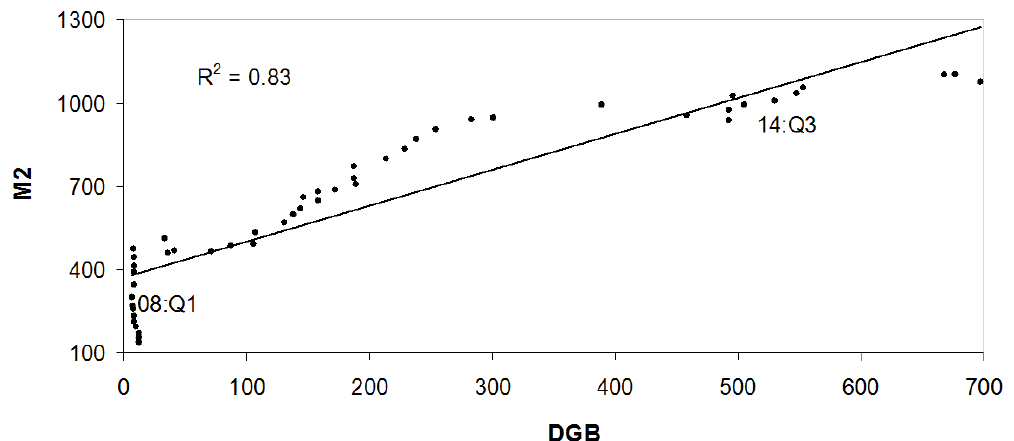
Figure 4. The correlation between Domestic Government Bonds in circulation (DGB) and broad money (M2) , Q1 2005 – Q2 2017 (bln. UAH) Source: National Bank of